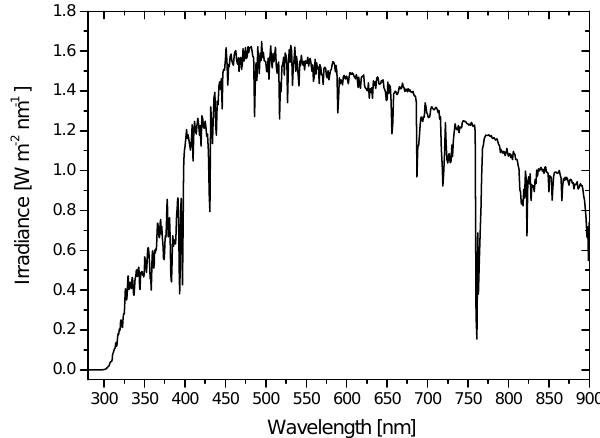
Figure C1. Direct spectral irradiance (ASTM